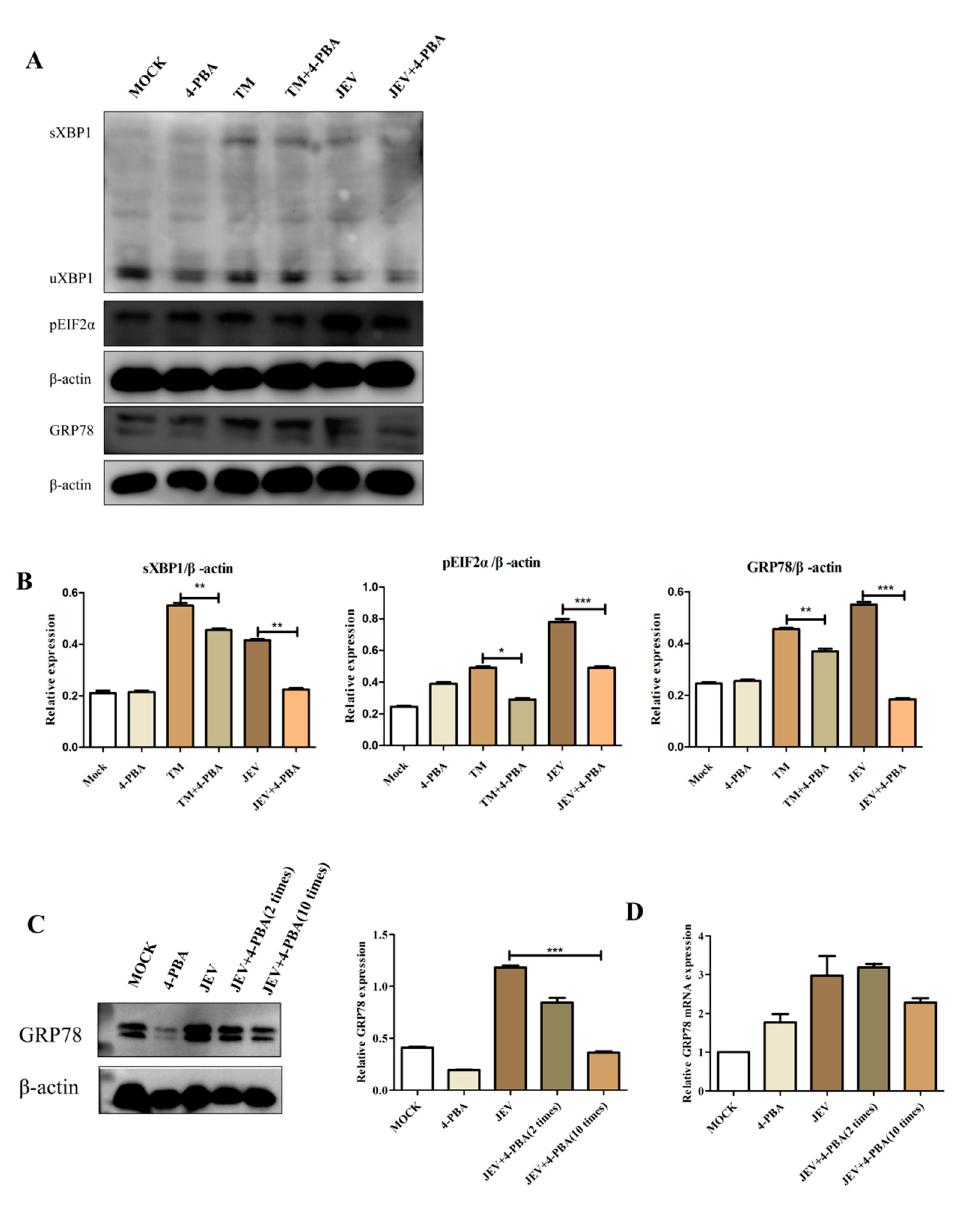
Figure 3. 4-PBA inhibits JEV-induced activation of the IRE1 and PERK pathways. ( A ) The protein levels of GRP78, pEIF2 α , sXBP1 (Abcam, Cambridge, UK) were determined using western blot. ( B ) Densitometry scans of the GRP78, pEIF2 α and sXBP1 band in ( A ). ( C ) We have confirmed that 4-PBA can inhibit the expression of GRP78 mRNA and protein ( D ) in brain tissue. * p < 0.05; ** p < 0.01; *** p < 0.001.